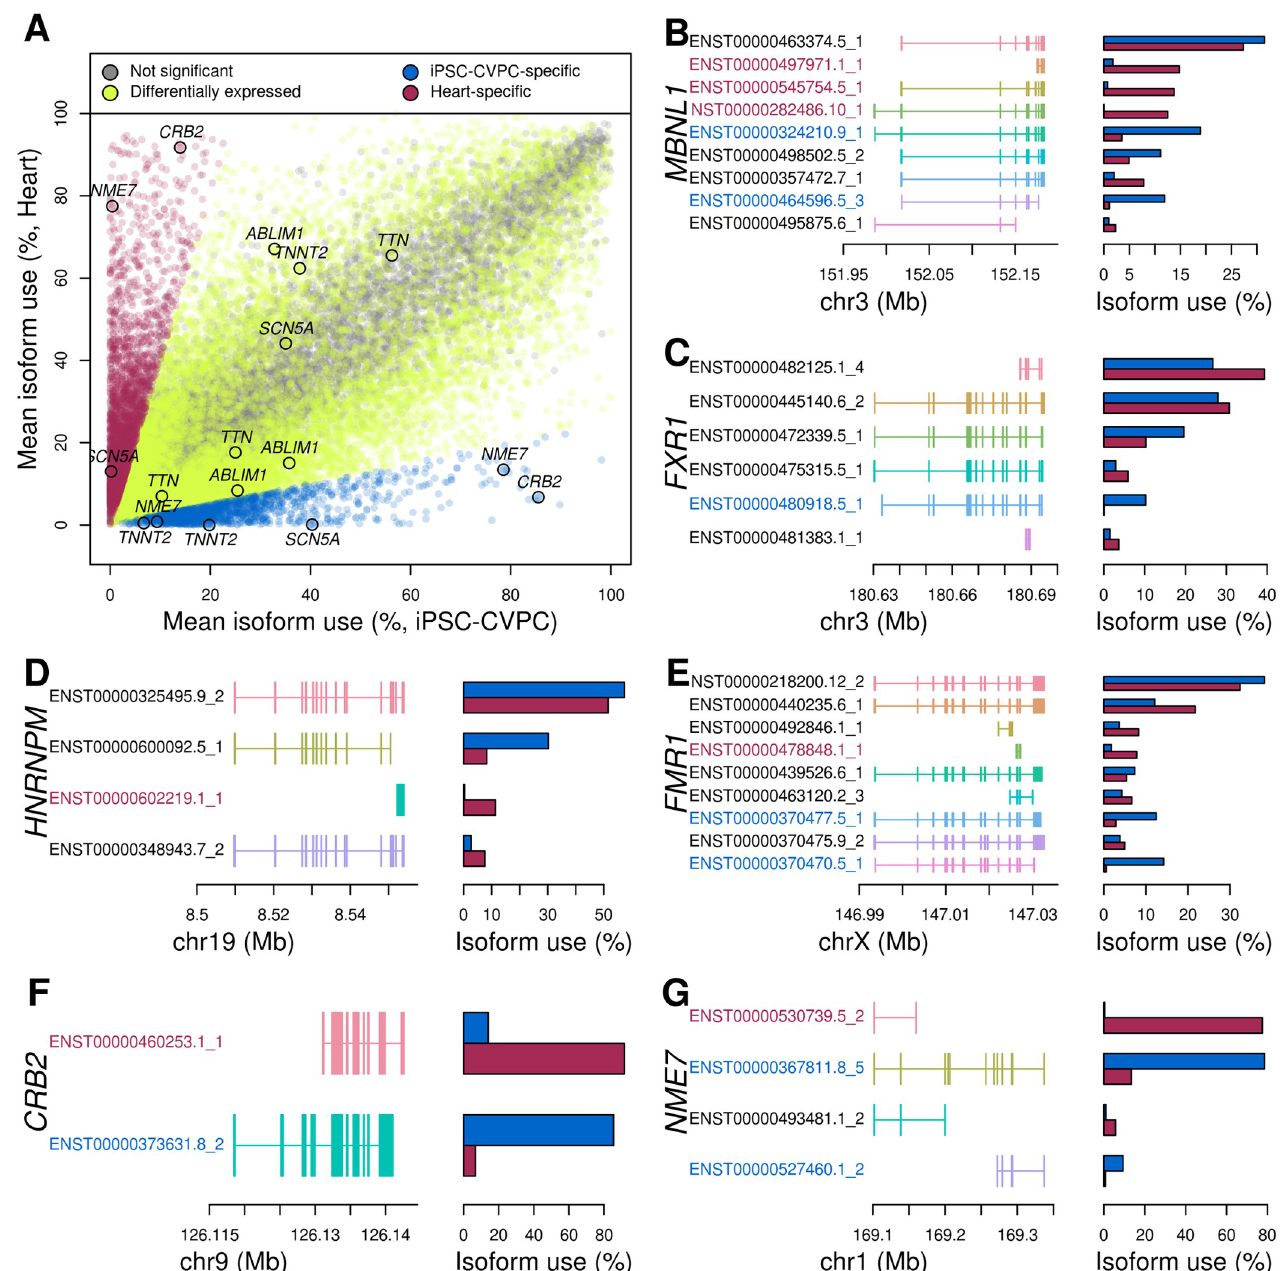
Fig 2. Large-scale isoform switching occurs between fetal-like iPSC-CVPC and heart tissue. (A) Scatter plot showing differential usage between adult heart and iPSC-CVPC for all expressed isoforms. iPSC-CVPC- and adult heart-specific isoforms are shown in blue and purple, respectively (absolute value of the log 2 ratio between mean isoform use between iPSC-CVPC and adult heart > 2 and FDR < 0.05). All other differentially expressed isoforms are shown in yellow (FDR < 0.05). Isoforms not differentially expressed are shown in gray. Isoform switching occurs between fetal-like iPSC-CVPC and adult heart for four RBPs (B-E) and two genes (F-G) with known cardiac functions. Left side of the figure represents the exon structure of each expressed isoform; the barplots on the right show the mean isoform use (%) of each isoform in iPSC-CVPC (blue) and adult heart (purple). Isoform IDs highlighted in blue are iPSC-CVPC-specific and isoform IDs highlighted in purple are adult